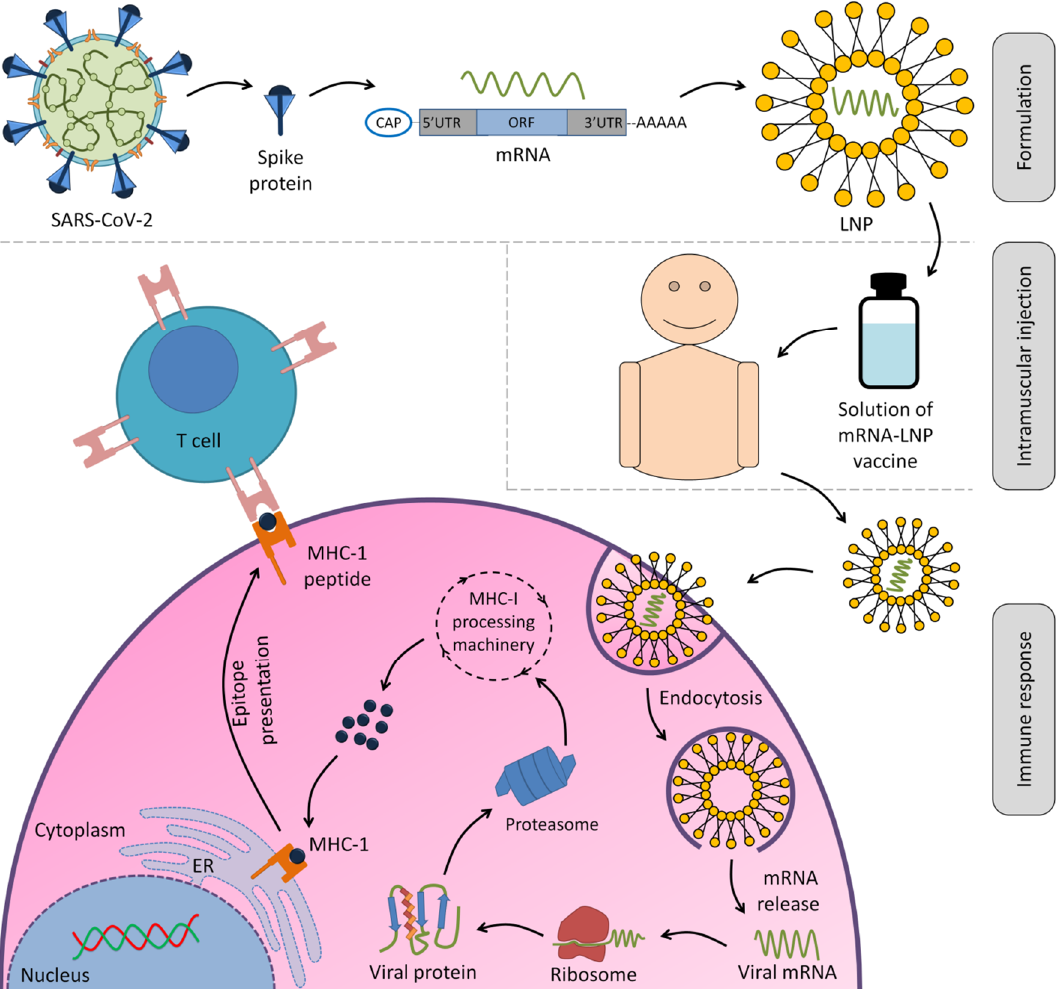
Figure 5. Scheme of the mRNA vaccine’s mechanism of action. The delivery of mRNAs is ac- complished via a carrier to improve mRNA distribution and stability in the cell, such as an LNP. Afterwards, the LNP–mRNA vaccines are injected intramuscularly. The mRNAs are released and translated by the host protein synthesis machinery after LNP–mRNAs enter the host cells. The produced proteins are degraded by proteasomes, resulting in peptides that are then linked to MHC I molecules and presented on the surface of host antigen-presenting cells. CD8+ T lymphocytes identify the peptide-MHC I complexes and respond with cellular immunological responses. MHC, major histocompatibility complex; ER, endoplasmic reticulum; UTR, untranslated region; ORF, open reading